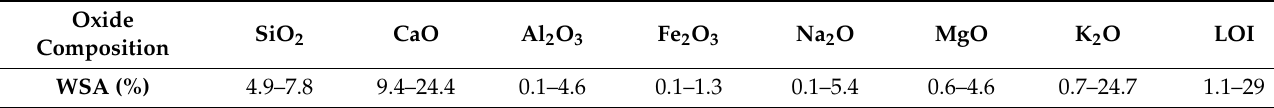
Table 2. Oxide composition of WSA [15–18,40–42].